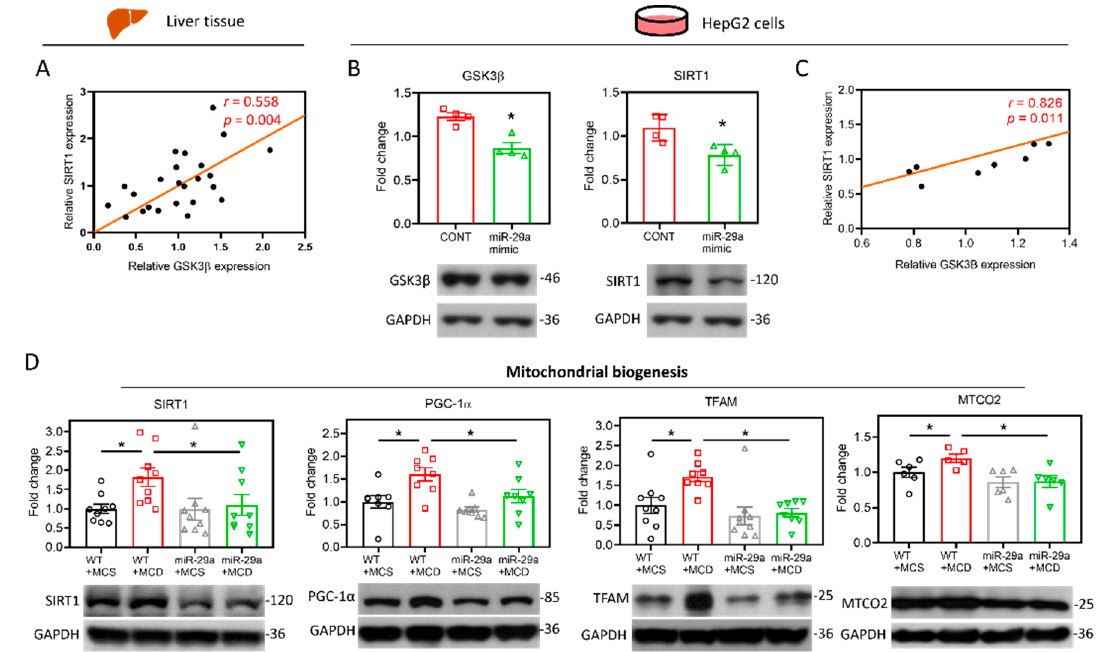
Figure 6. miR-29a/GSK3 β axis counterbalances the perturbation of SIRT1-mediated mitochondrial biogenesis. ( A ) Pearson’s correlation of GSK3 β with SIRT1 in the mouse liver (N = 24). ( B ) Human HepG2 cells were transfected with miR negative control (CONT) or miR-29a mimic for 24h. The protein expression level of GSK3 β and SIRT1 was determined by Western blot. GAPDH level as loading control (N = 4). ( C ) Pearson’s correlation of GSK3 β with SIRT1 in the HepG2 cells (N = 8). * p < 0.05 compared with CONT group. ( D ) Representative blots and densitometric results of SIRT1, PGC-1 α , TFAM and MTCO2, which represent indicators of mitochondrial biogenesis. N = 6–9 in each group.